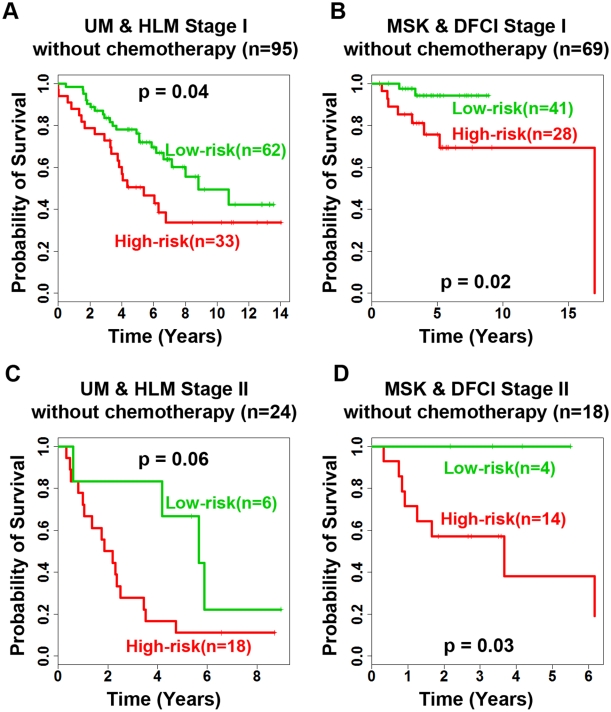
Evaluation of the 12-gene signature in treatment selection.The 12-gene signature separated high- and low-risk groups from patients who did not receive chemotherapy (log-rank P<0.05) in the following cohorts: (A) stage I patients from the training cohort, (B) stage I patients from two test cohorts, (C) stage II patients from the training cohort, (D) stage II patients from the two test cohorts.